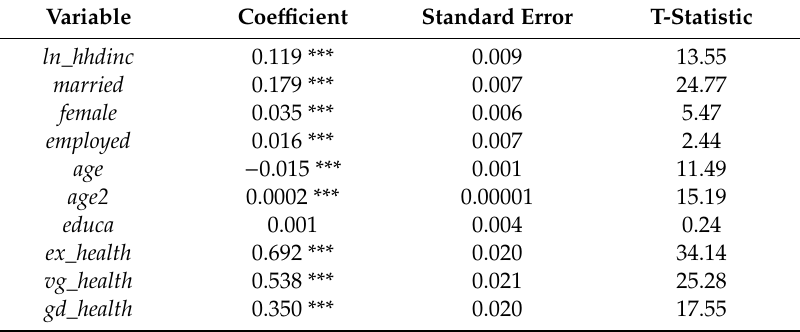
Table 2. Empirical results showing the impact of Mountain Pine Beetle (MPB) on life satisfaction for residents of Colorado